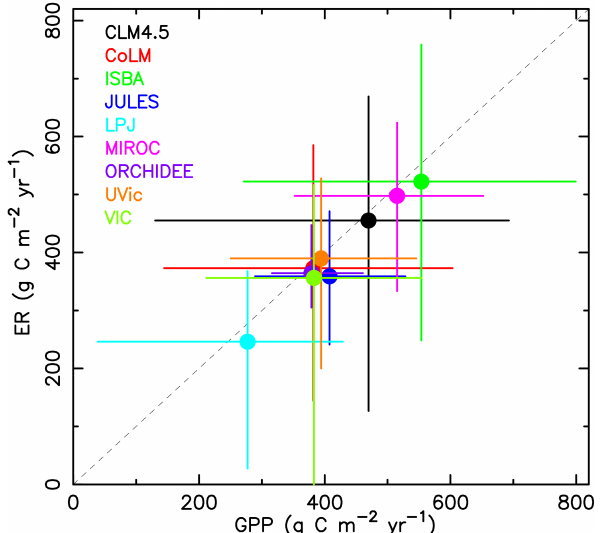
Figure 7. Spatially averaged ER vs. GPP over the period 1960– 2009. Horizontal and vertical lines span the range across the 5th and 75th percentiles for GPP and ER, respectively. The GPP 5th and 75th percentiles are shown in Fig. 6. NEP is equal to the difference GPP minus ER.